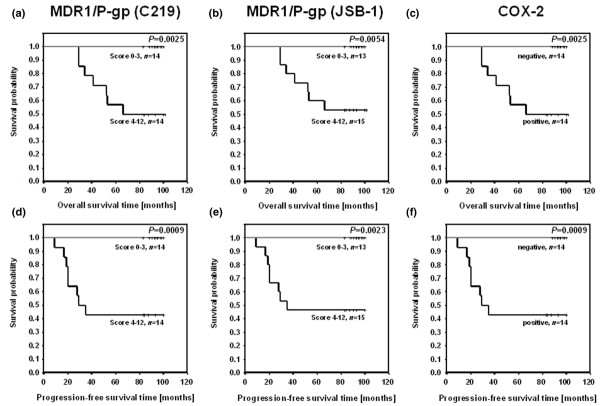
Kaplan-Meier analysis of 28 breast cancer patients treated postoperatively with chemotherapy. (a) Patients with a lower overall immunoreactivity score for MDR1/P-glycoprotein (MDR1/P-gp) expression detected with antibody C219 exhibit significantly longer overall survival. (b) Patients with a lower overall immunoreactivity score for MDR1/P-gp expression detected with antibody JSB-1 exhibit significantly longer overall survival. (c) Cyclooxygenase-2 (COX-2) negative cases exhibit significantly longer overall survival. (d) Patients with lower overall immunoreactivity score for MDR1/P-gp expression detected with antibody C219 exhibit significantly longer progression-free survival. (e) Patients with lower overall immunoreactivity score for MDR1/P-gp expression detected with antibody JSB-1 exhibit significantly longer progression-free survival. (f) COX-2 negative cases exhibit significantly longer progression-free survival.